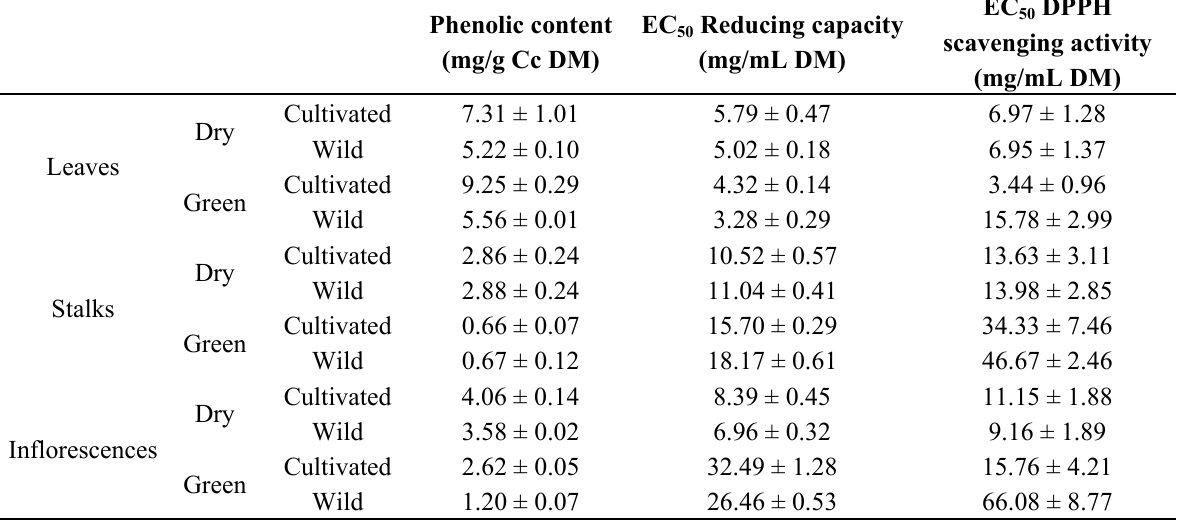
values for reducing capacity and 2,2-diphenyl- Table 1. Total phenolic contents and EC 50 1-picrylhydrazyl (DPPH) scavenging activity of different Cynara cardunculus (Cc) extracts. Each value represents the mean ± S.D. of three determinations.